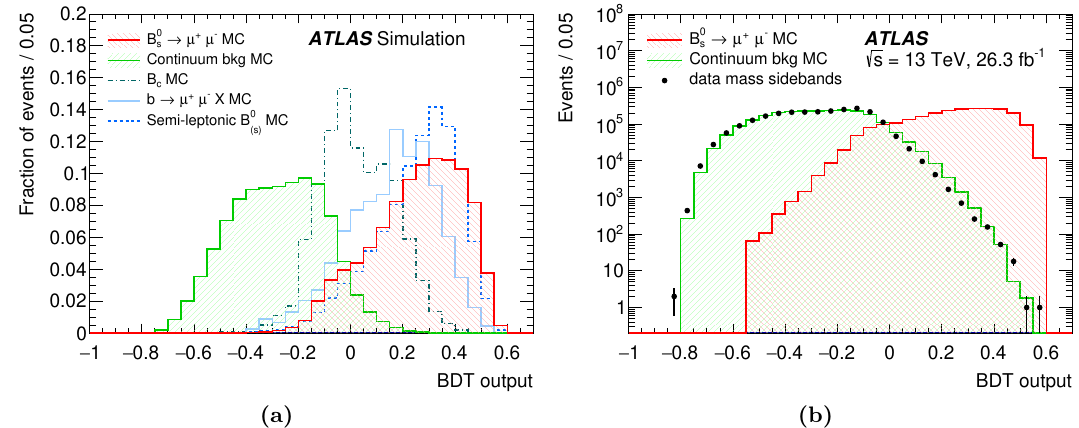
Figure 2. BDT output distribution for the signal and background events after the preliminary se- lection and before applying any reweighting to the BDT input variables: (a) simulation distributions for B 0 ! (cid:22) + (cid:22) (cid:0) signal, continuum, partially reconstructed b ! (cid:22) + (cid:22) (cid:0) X events and B c decays; (b) s dimuon sideband candidates (which also include prompt contributions, mainly at lower BDT values and not simulated in the continuum MC sample), compared with the continuum MC sample and the simulated signal. All distributions are normalised to unity in (a) and to data sidebands in (b).